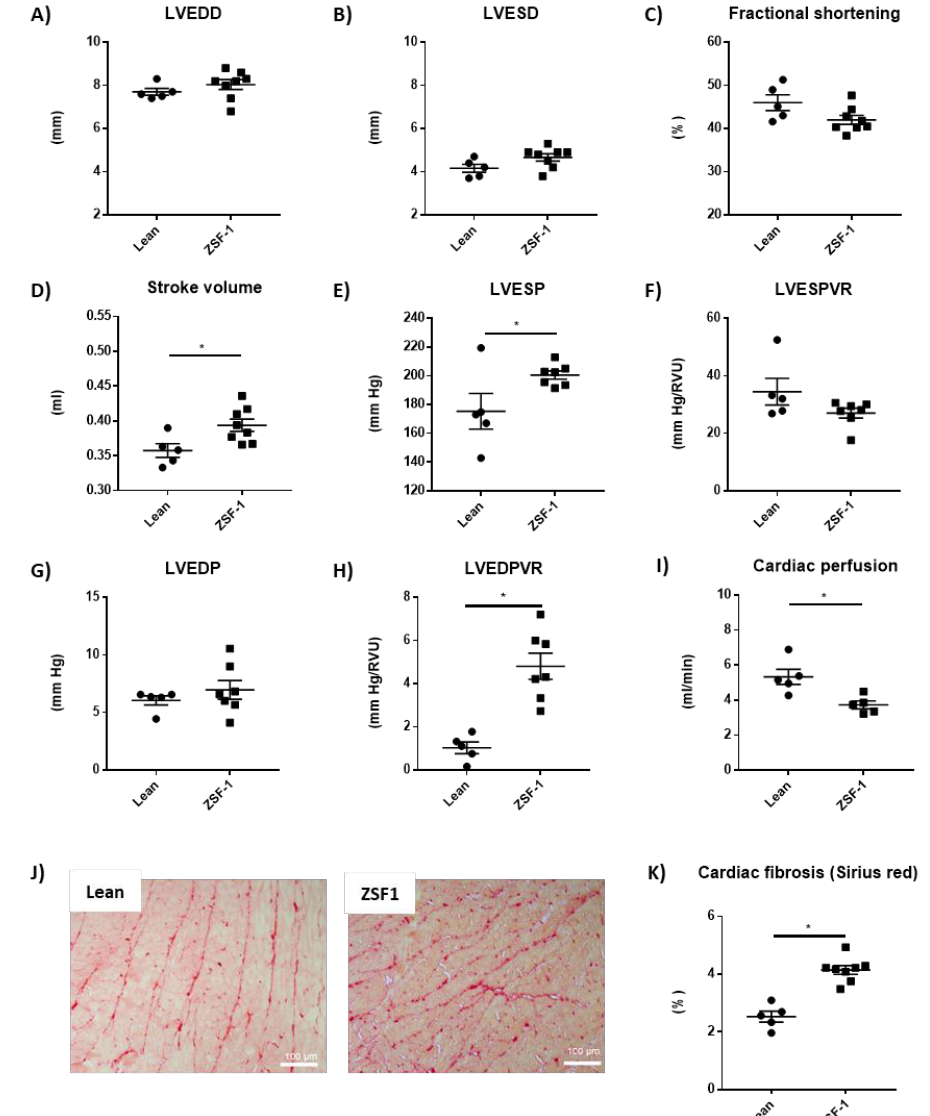
Figure 2. Impaired LV diastolic function is associated with a decrease in left ventricle perfusion and myocardial interstitial fibrosis in the ZSF1 rats. Left ventricle end-diastolic diameter ( A ), left ventricle end-systolic diameter ( B ), fractional shortening ( C ), stroke volume ( D ), left ventricle end-systolic pressure ( E ), left ventricle end-systolic pressure–volume relationship ( F ), left ventricle end-diastolic pressure ( G ), left ventricle end-diastolic pressure–volume relationship ( H ) and left ventricle tissue perfusion ( I ). Representative light microphotographs (20× magnification) of rat kidney sections stained with Sirius red ( J ) and kidney fibrosis quantification ( K ). Student’s t -test was used for statical analysis, n = 5 −8 . * p < 0.05 vs. lean.